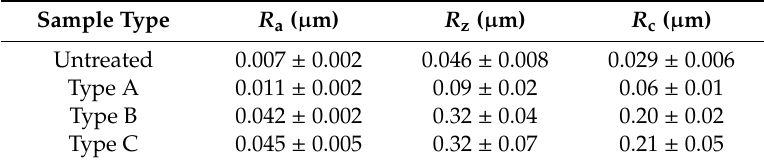
Figure 4. X-ray diffraction patterns of samples untreated ( a ) and Type-A ( b ), Type-B ( c ) and Type-C ( d ) treated. 3.2. Water Contact Angle The apparent water contact angle values for untreated and treated samples are reported in Table 2. As an example, the images of drops on the surface of untreated and treated samples are shown in Figure 5. Untreated steel had hydrophilic behavior, but with a fairly large contact angle. After the treatment, for all the samples a significant increase of contact angle values was observed. For Type-A and Type-B samples the surface became hydrophobic, while for Type-C samples it remained hydrophilic, even with large contact angle values.